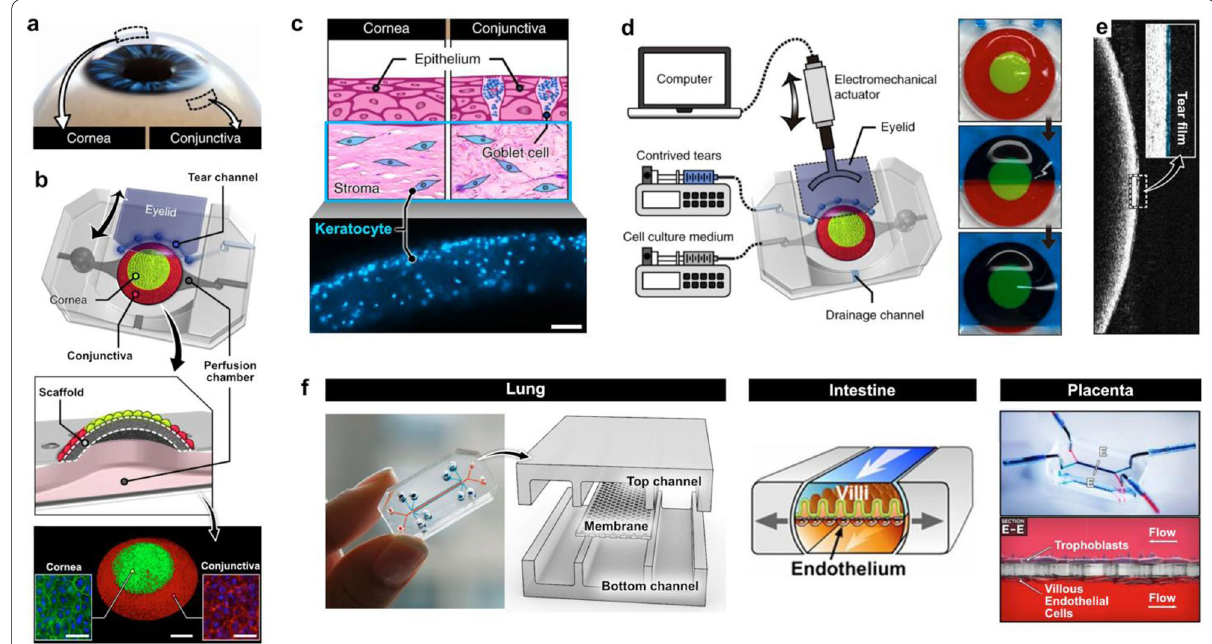
Fig. 1 Design process of organ-on-chip models. a The blinking eye-on-a-chip mimics the human eye through a reductionist approach by targeting the ocular surface and its relevant components, the cornea and conjunctiva, as key functional units b and coculturing these cell types over a dome-shaped scaffold. Scale bars, 1 mm (middle), 50 µm (insets). c The underlying stroma is also modelled by embedding keratocytes into the scaffold. Scale bar, 100 µm. d The unique blinking property of the eye is recapitulated through electromechanical actuation, e which creates a tear film with physiological thickness. f This design principle has been used to model other organs such as the lung, intestine, and placenta in a conventional device consisting of overlapping perfusable microchannels separated by a semiporous